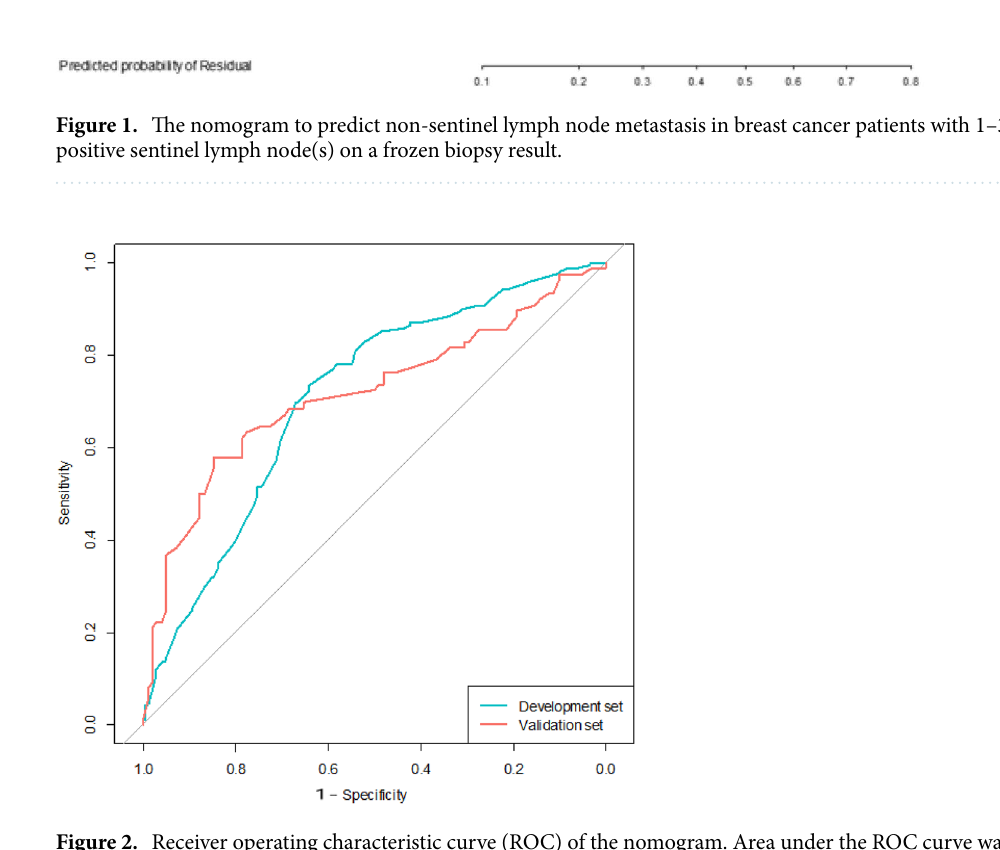
Figure 2. Receiver operating characteristic curve (ROC) of the nomogram. Area under the ROC curve was 0.709 on the development set and 0.715 on the validation set, respectively.